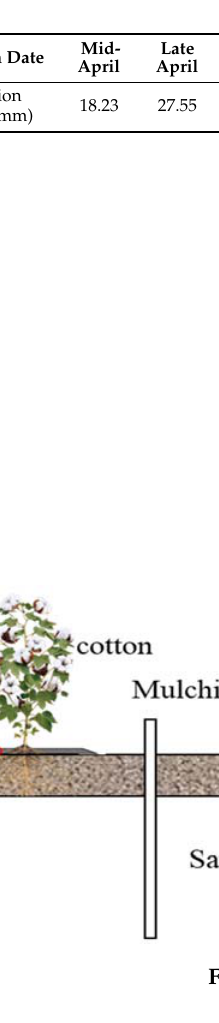
Table 2. Study area irrigation system.